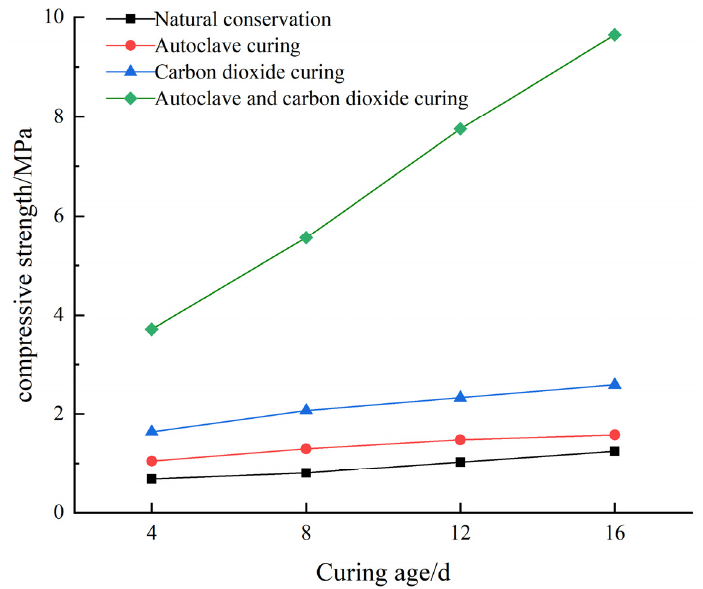
Figure 7. Bearing strengths of gray brick under different curing methods.